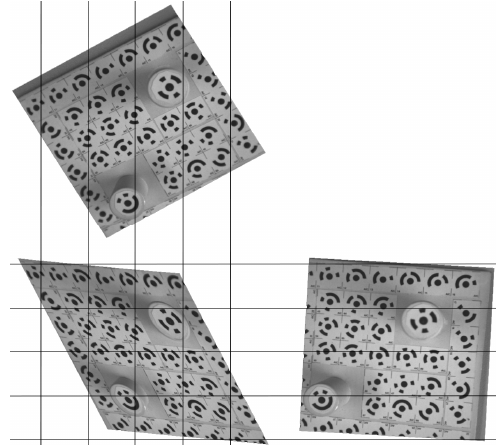
Figure 3. Rectified image triplet and epipolar lines.